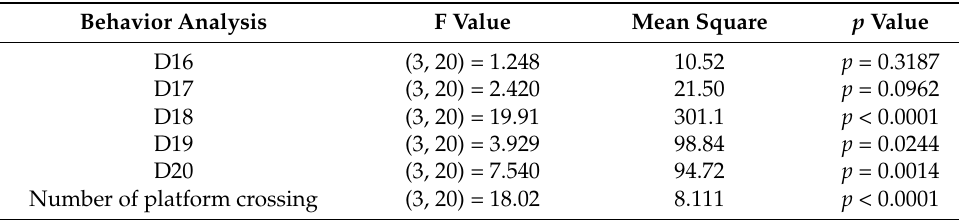
Table 2. Table for ANOVA results for behavior analysis data.